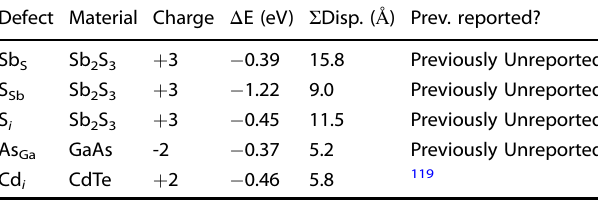
Table 2. Cation – anion rebonding. Energy difference and summed atomic displacements ( Σ Disp.) between the ground state identi fi ed by our method and the metastable con fi guration a found when relaxing the ideal, undistorted defect structure (i.e., Δ E = E ground − E metastable ). Defect Material Charge Δ E (eV) Σ Disp. ( Å ) Prev.